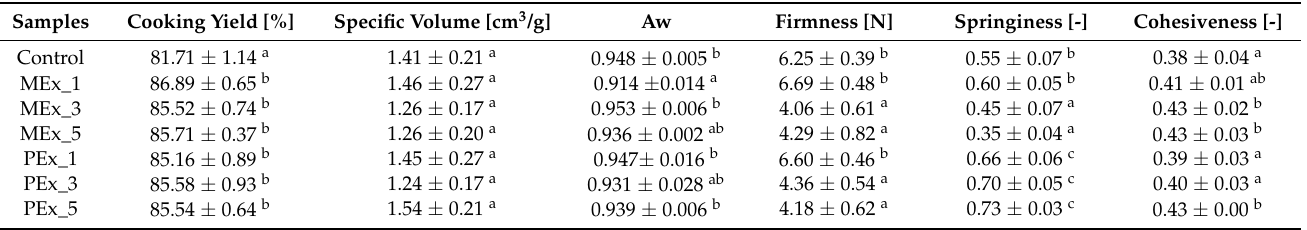
Table 3. Mean ± SD of cooking yield, specific volume, water activity, and selected texture components of